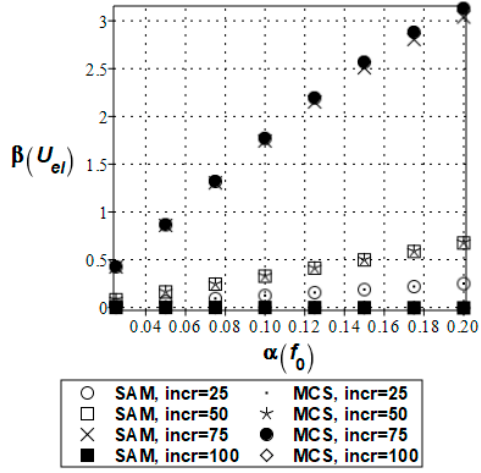
Energies 2020 , 13 , x FOR PEER REVIEW Figure 8. Coefficients of variation of elastic energy fluctuations. Figure 8. Coe ffi cients of variation of elastic energy fluctuations.